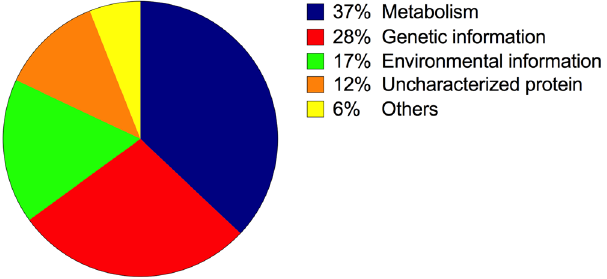
Figure 2. E. coli magainin I–resistant exclusive protein classification. Graphical distribution of E. coli magainin I–resistant exclusive proteins according to KEGG biological